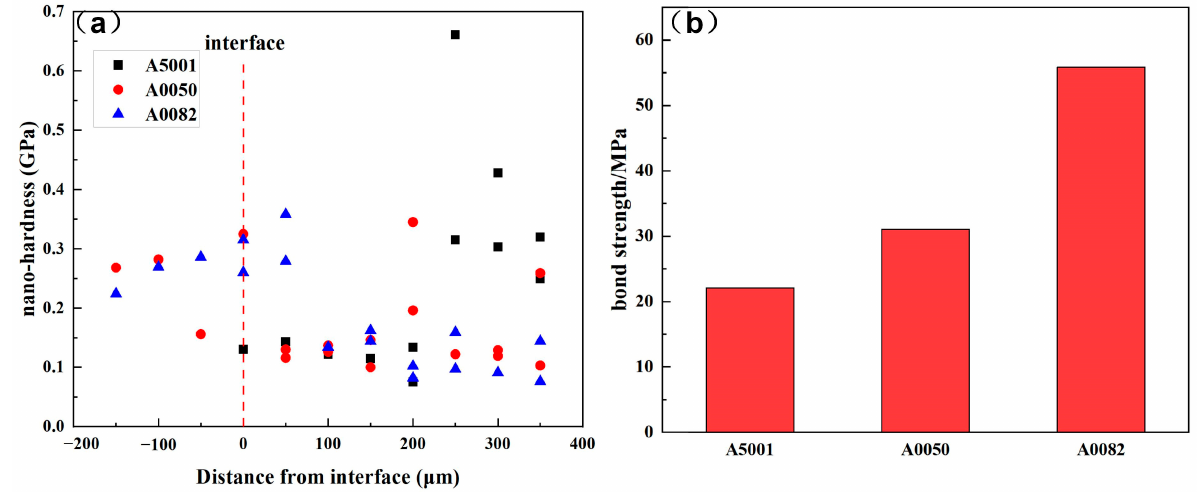
Figure 4. Coatings prepared from each of the three powder materials ( a ) nano-hardness distribution at the interface; ( b ) bonding strength.